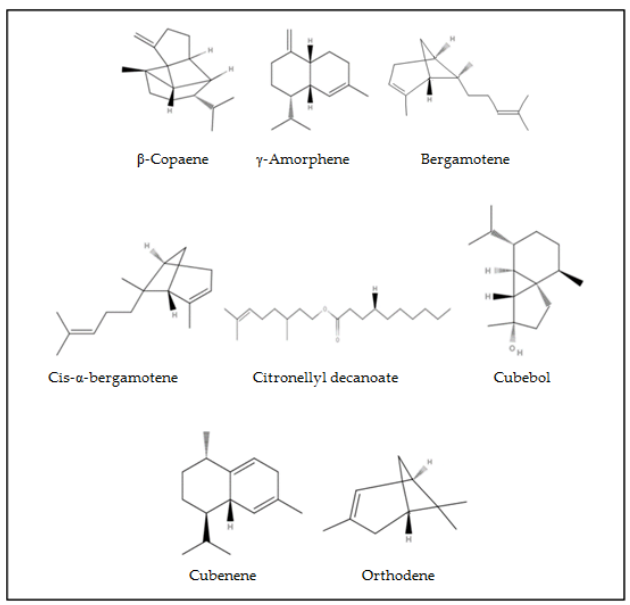
Figure 3. First time extracted and identified chemical compounds in essential oil of nutmeg.